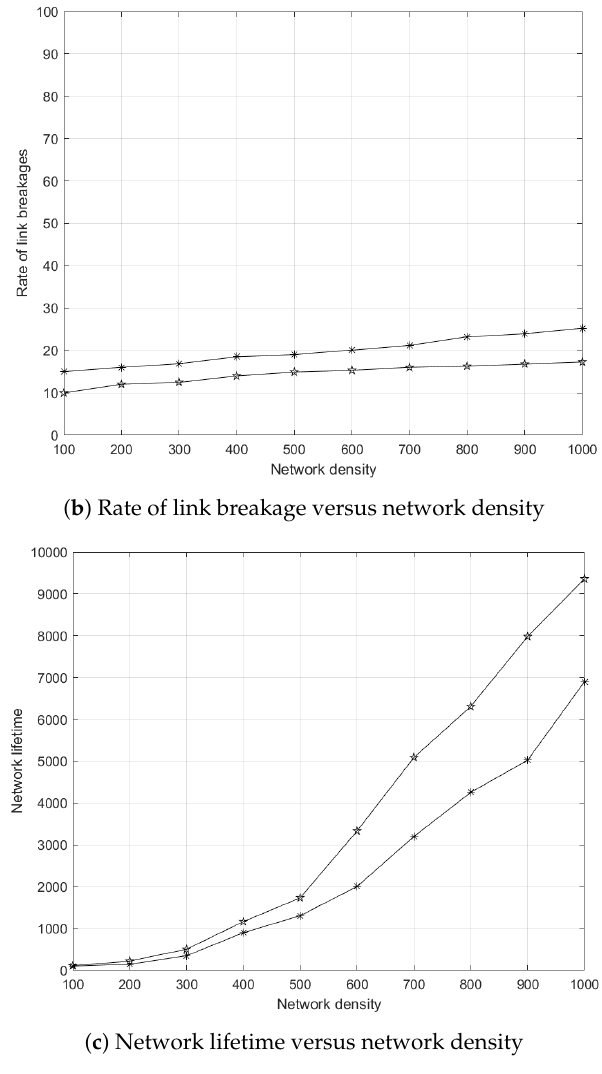
Figure 6. Graphical results for the effects of network density on DQN. Learning rate α = 0.001 achieves the lowest energy consumption and rate of link breakages, as well as the highest net- work